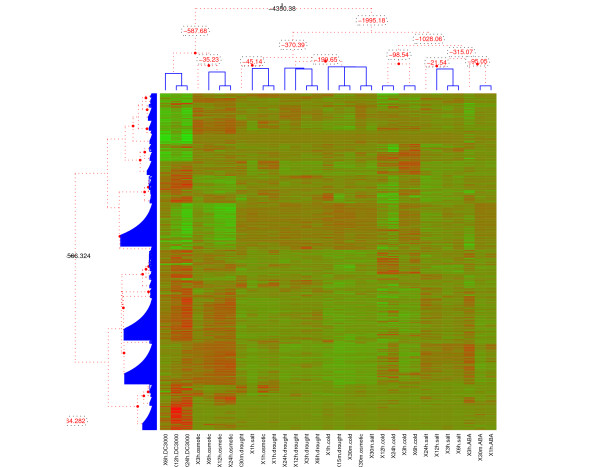
Clustering of 880 genes and 31 conditions of A. thaliana. Clustering of 880 genes and 31 conditions of A. thaliana, subjected to a variety of biotic and abiotic stresses (as used by [26]). Shown are transcript profile clustering (left), condition clustering (above and below) and the corresponding 2D heat map, aligned with the 1D dendrograms. Red dashed lines are merges our algorithm prefers not to make. The numbers on the branches are the log odds for merging ().